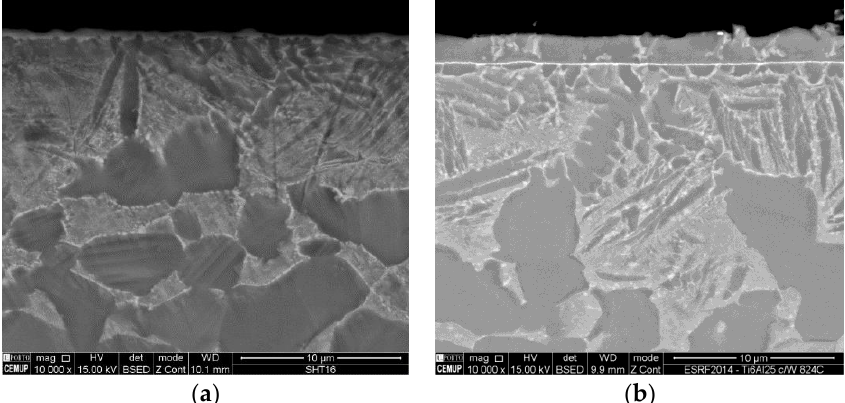
Figure 5. Cross-section SEM BSE images of Ni/Ti multilayer thin films with 25 nm period ( a ) without or ( b ) with W interlayer after HT at 900 °C.